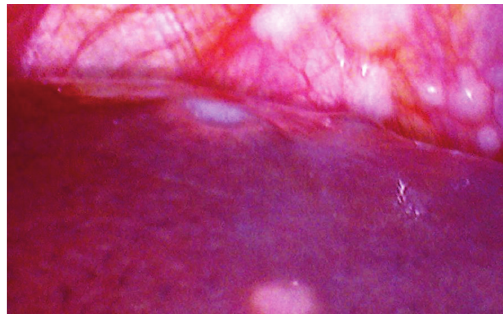
Figure 1: Diagnostic laparoscopy showing liver metastasis.